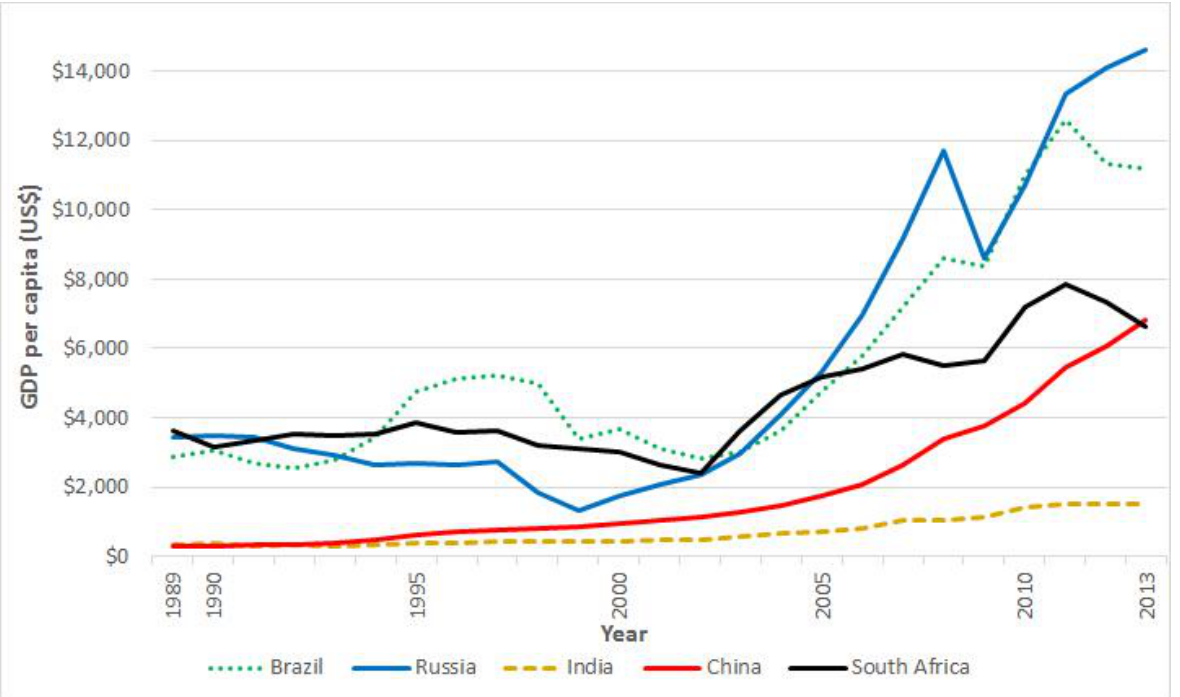
Figure 2. Gross domestic product (GDP) per capita for BRICS countries, 1989 to 2013. Source: World Bank